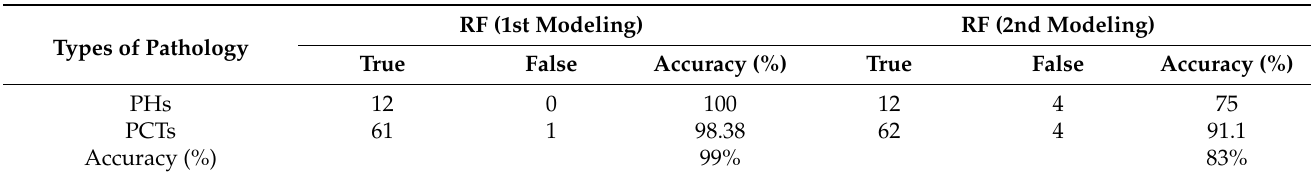
Table 6. Details of the confusion matrix for PHs and PCTs using the highest learning MLP classifier (RF) for all patients in the first and second